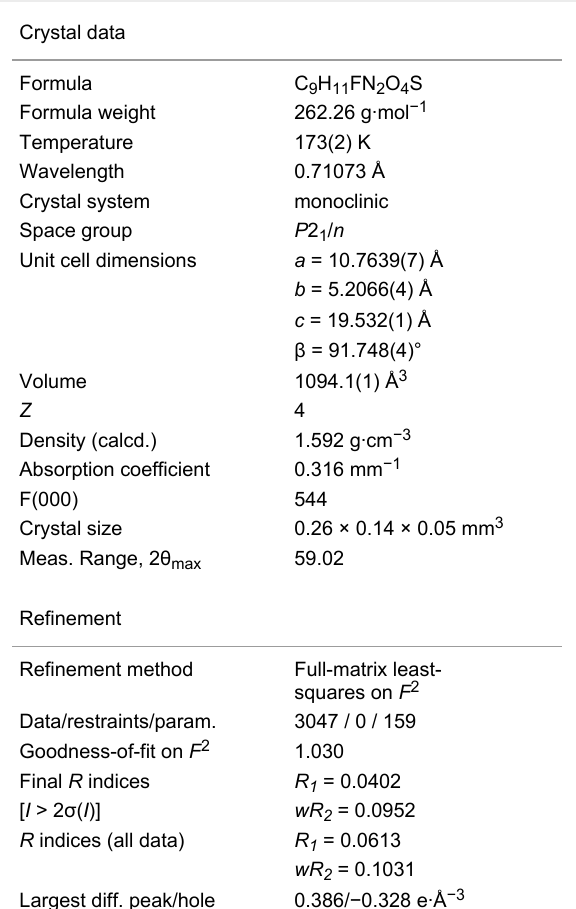
Table 1: Crystal data and structure-refinement parameters for com- pound 18